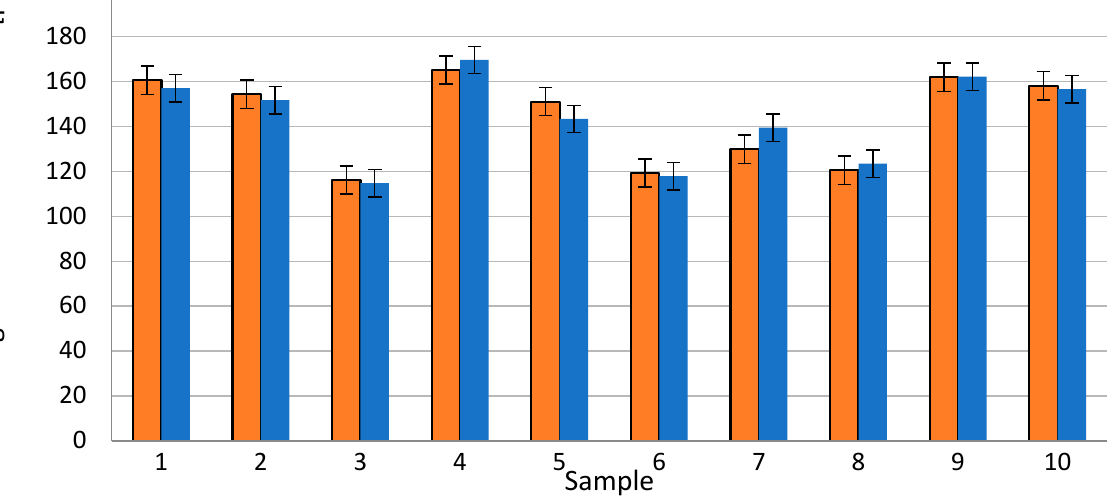
Figure 2. Overview of the passage time of the ultrasonic wave through the individual ceramic brick samples.